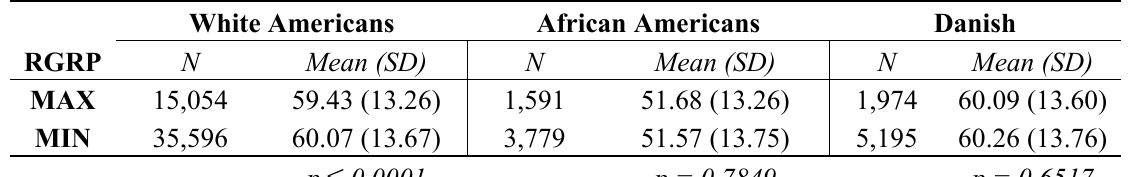
Table 4. Counts and Mean age at death by solar Max and solar MIN for the MS cohort data.